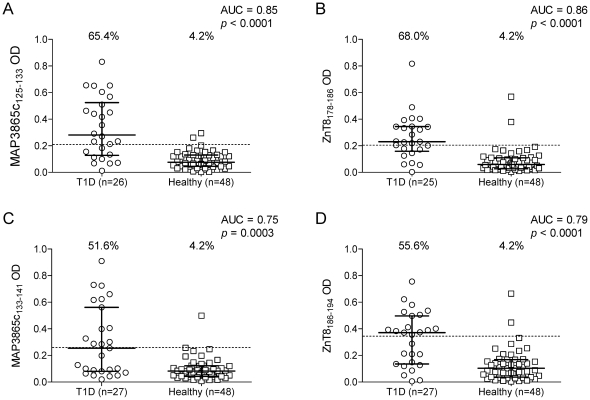
Prevalence of Abs against homologous MAP3865c and ZnT8 epitopes in T1D patients.Prevalence of Abs against MAP3865c125–133 (A) and its homologous ZnT8178–186 (B); and against MAP3865c133–141 (C) and its homologous ZnT8186–194 (D) in T1D and healthy subjects. Data representation is the same as in Fig. 1.